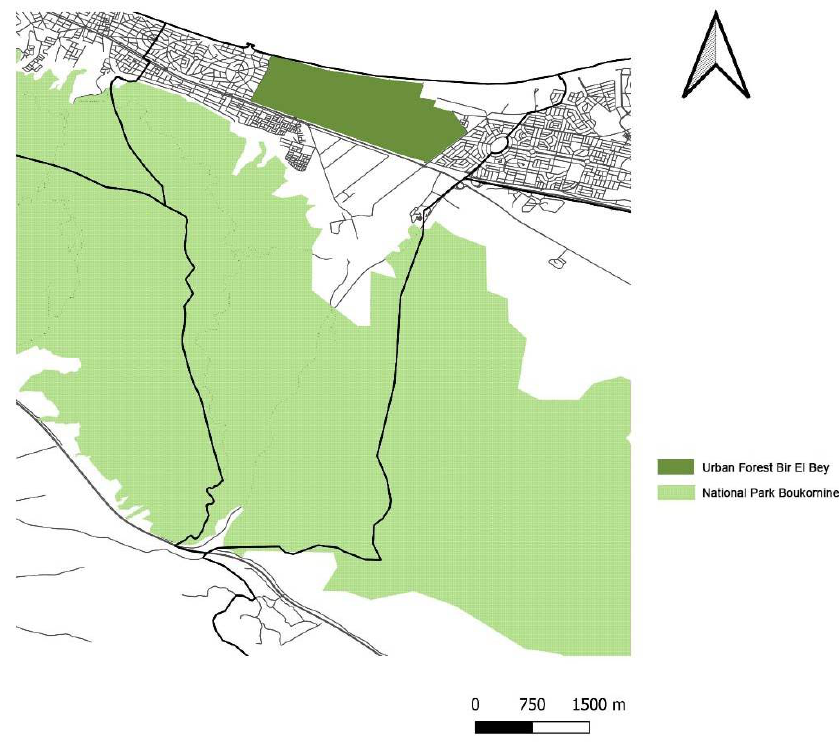
Figure 2. Bir El Bey Forest’s perimeter .